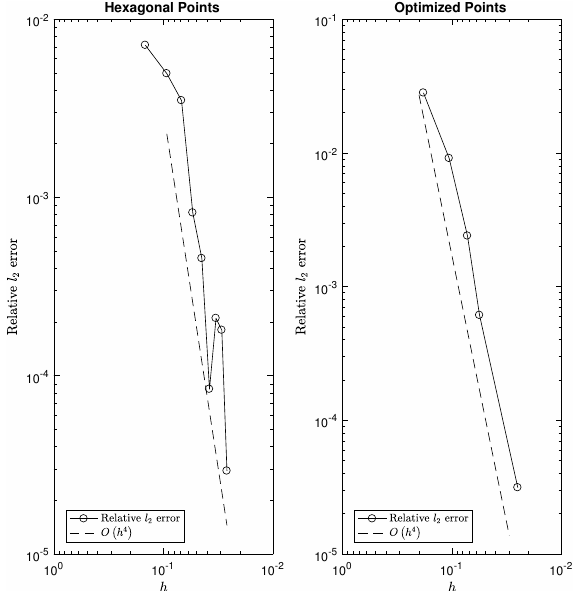
Figure 21. Solution convergence for the wave equation with hyperviscosity for hexagonal and optimized